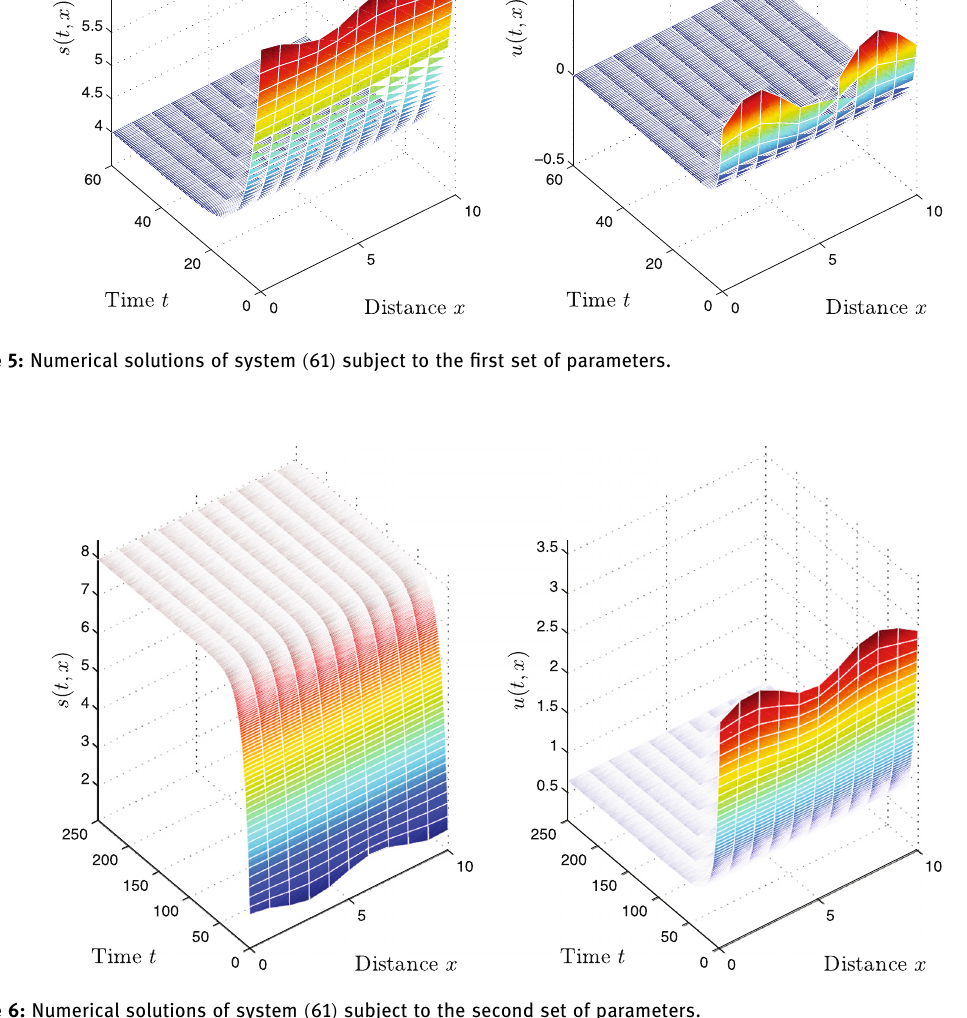
Figure 6: Numerical solutions of system ( 61 ) subject to the second set of